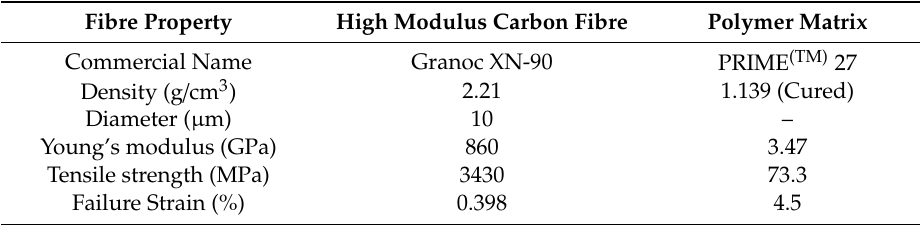
Table 1. Fibre and polymer matrix